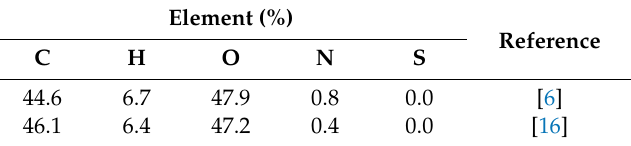
Table 2. Elemental analysis of the olive-pruning debris.